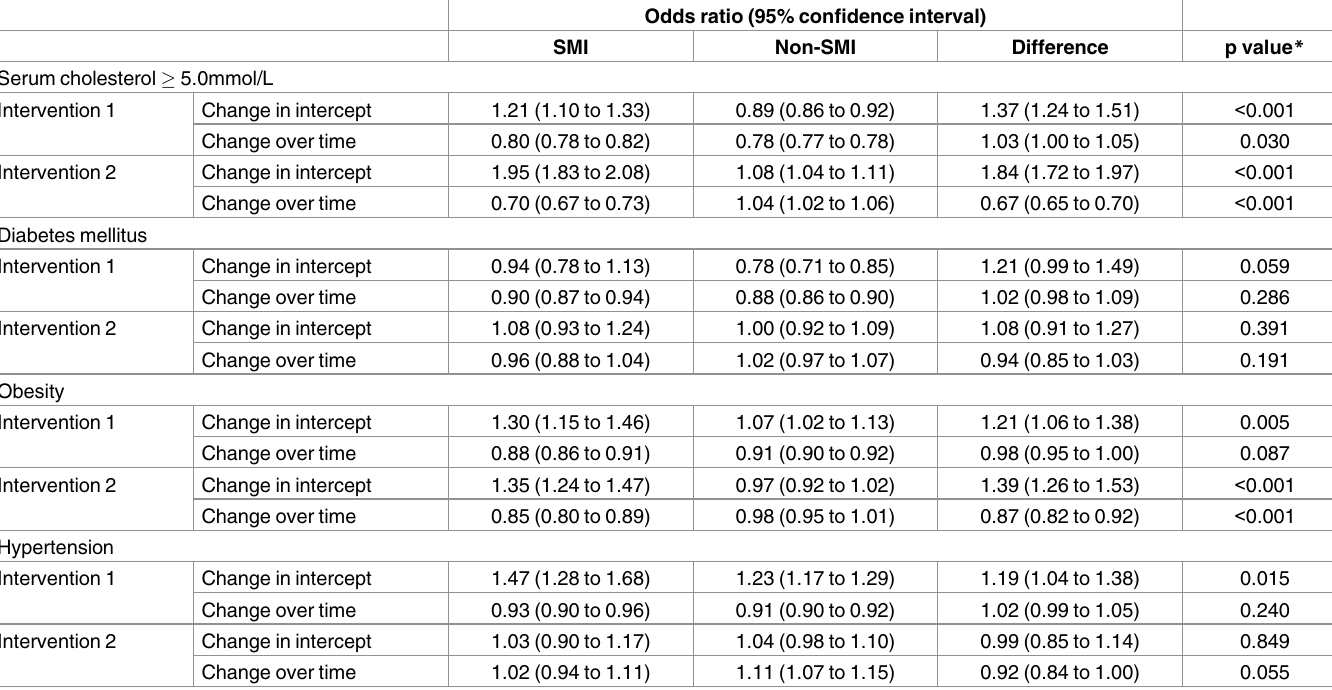
Table 2. Interrupted time series analyses results, reporting immediate changes in detection of cardiovascular risk factors and changes over time.